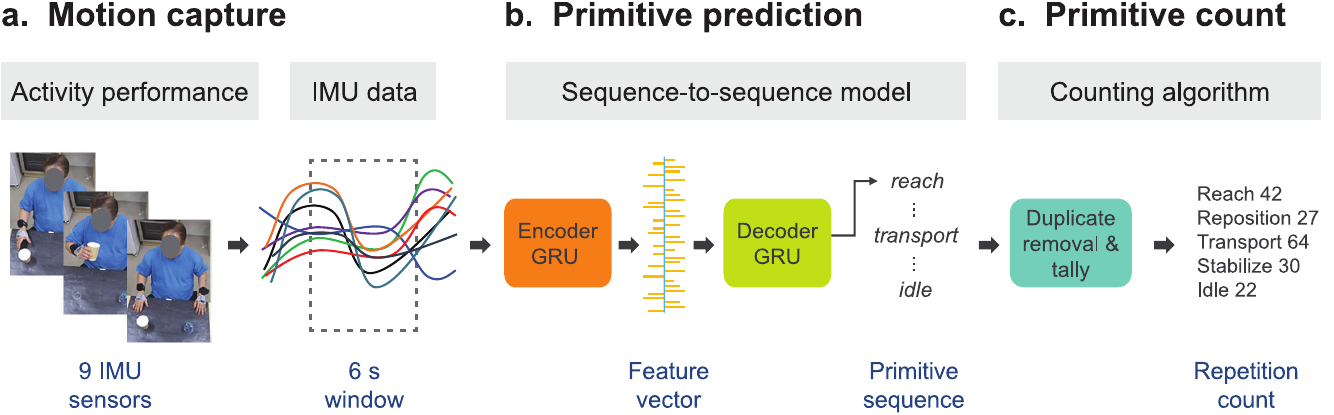
Fig 2. The PrimSeq pipeline. (A) Motion capture . Upper-body motion data are captured with IMUs during performance of rehabilitation activities. IMU data are divided into six-second windows. (B) Primitive prediction . The windowed IMU data are fed into the sequence-to sequence (Seq2Seq) deep learning model. Seq2Seq uses a Gated Recurrent Unit (GRU) to sequentially encode IMU data into a feature vector, which provides a condensed representation of relevant motion information. A second GRU then sequentially decodes the feature vector to generate the primitive sequence. (C) Primitive count . A counting algorithm then removes primitive duplicates at window boundaries and tallies the predicted